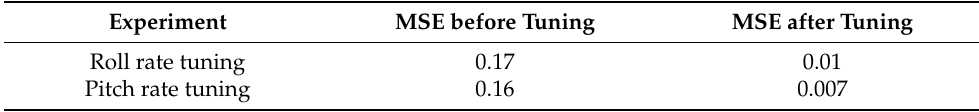
Table 2. The mean squared error (MSE) for hardware Experiment